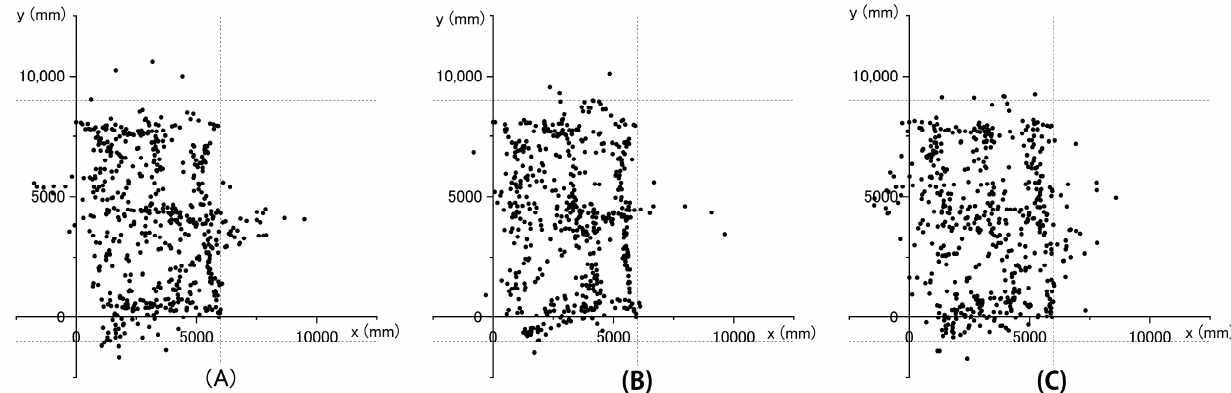
Figure 5. Indoor positioning results. Each dot indicates the position coordinates computed by the Wi-Fi RTT. The location information was calculated as the median value of the X- and Y -axis coordinates every second. The range enclosed by the dotted line and the Y -axis is the walking range. ( A–C ), indicate Experiments A, B, and C, respectively. The results of the WPM measurements are shown in Table 4 and Figure 6. Table 4. Descriptive statistics of dust measurement results.